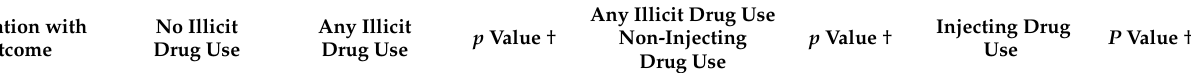
Table 4. Association of lifetime, and past-year illicit drug use with past-year suicidal behaviors, and past-year household food